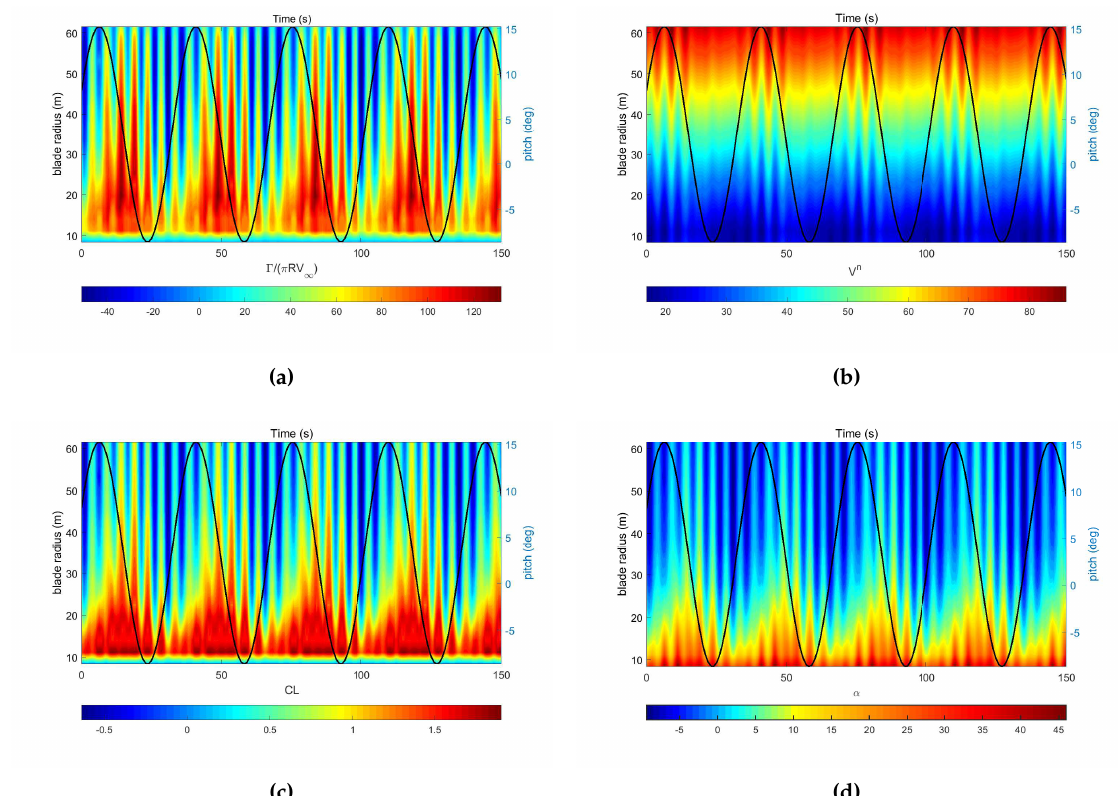
Figure 12. Time evolution of: ( a ) Γ / ( π RV ∞ ) ; ( b ) V n ; ( c ) C l ; and ( d ) α for the OHS above-rated